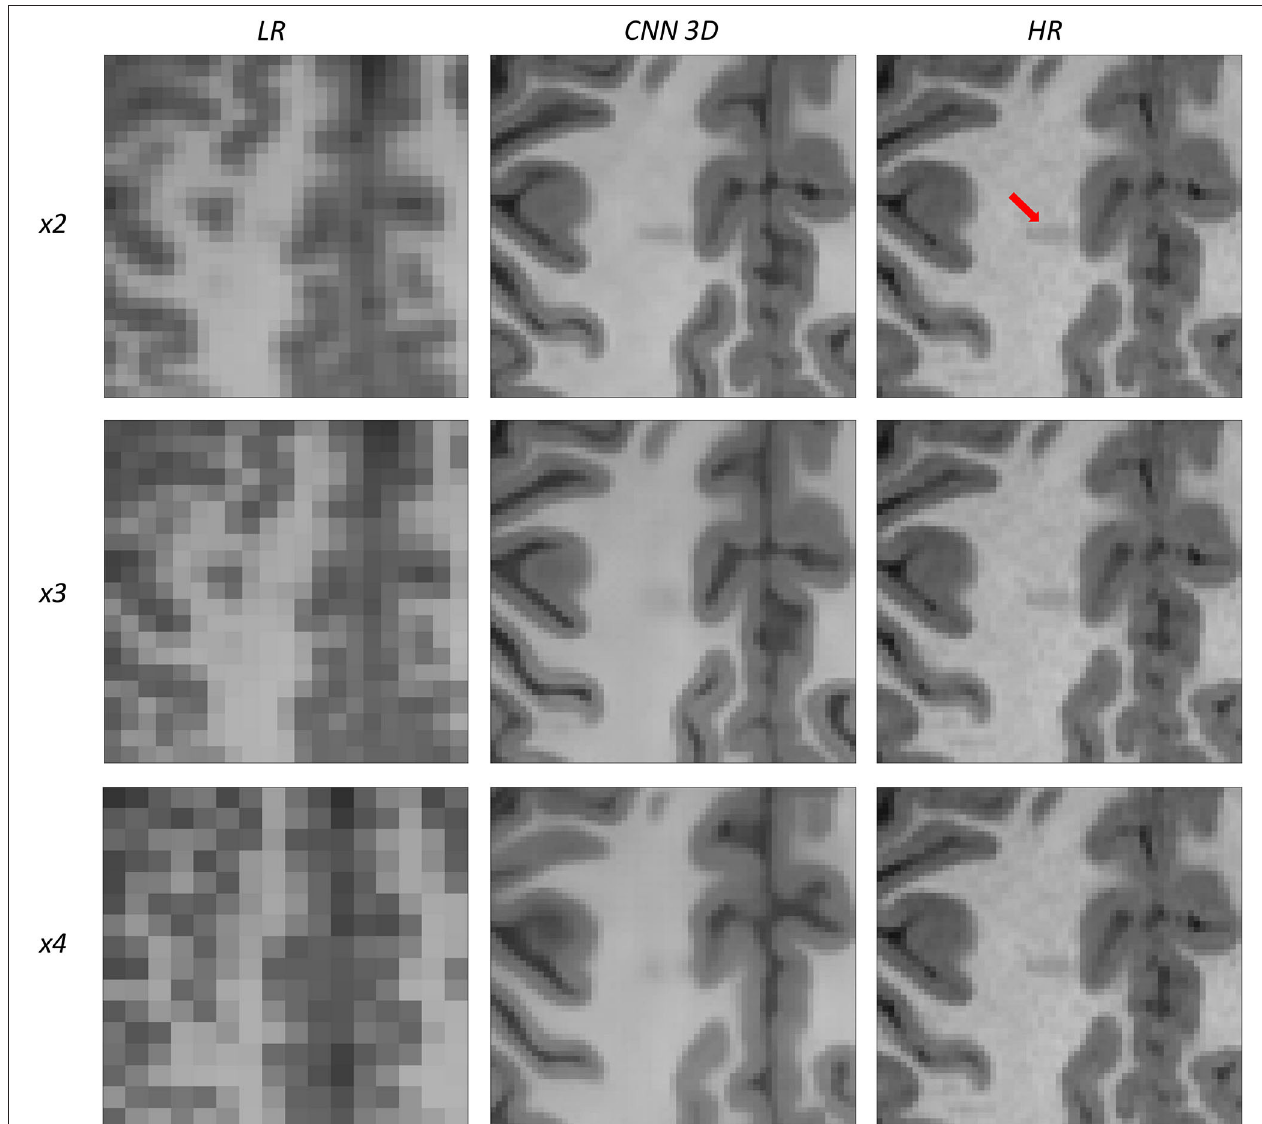
FIGURE 13 | Results of both CNN methods on three scaling factors of super-resolution on images of a patient with dysplasia. A specific region of a slice is shown, with the red arrow pointing to a lesion.